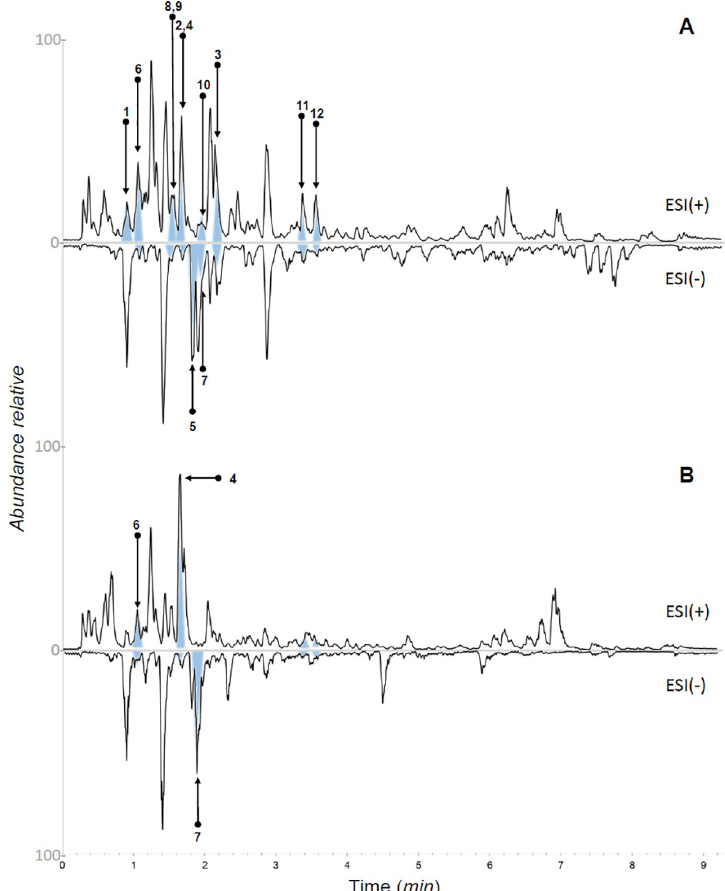
Fig 1. UHPLC-PDA-ELSD-MS analysis of the bioactive CH 2 Cl 2 fraction from EtOH extracts of Nectandra oppositifolia twigs (A) and (B) leaves in positive and negative ionization modes. The corresponding isolated compounds (1–12) from each sample are